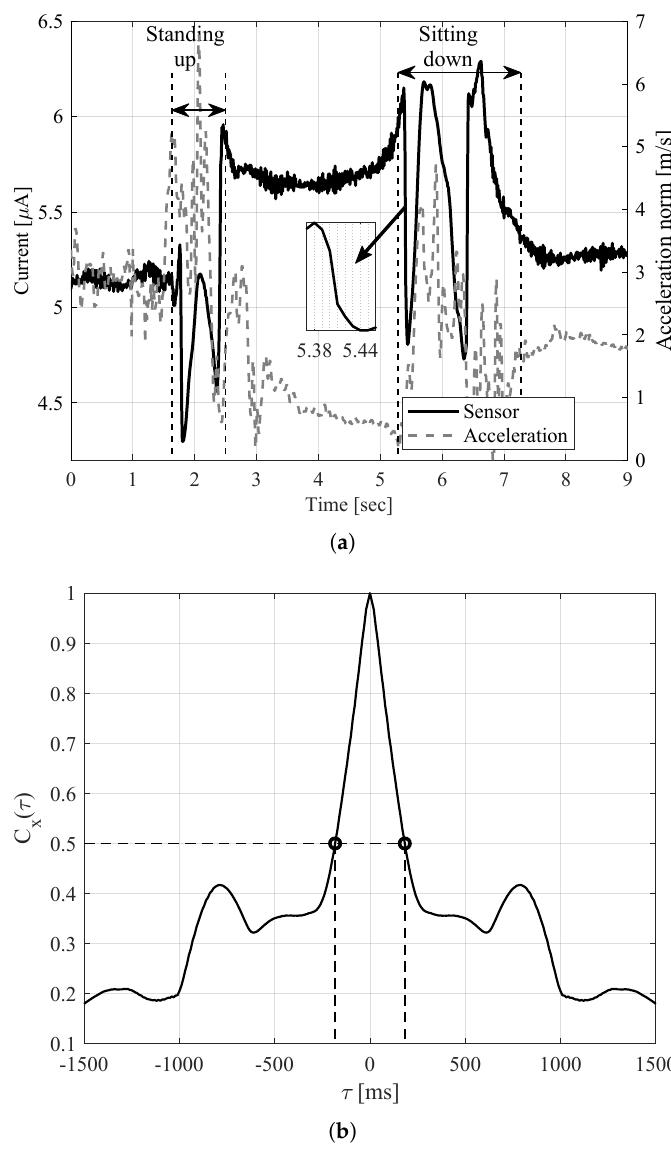
Figure 4. Illustrative example of channel behavior. ( a ) The received signal level with the corresponding acceleration vector norm. ( b ) The normalized auto-covariance function (ACF) of the received signal with coherence time of 183